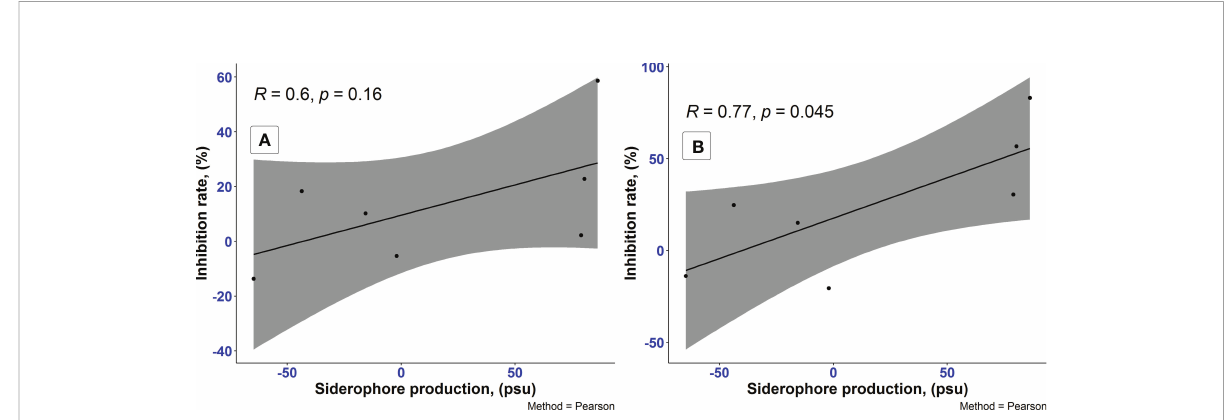
FIGURE 3 Analysis of correlation between the siderophore production of P. resinovorans SZMC 25872 and the growth inhibition of A. tumefaciens SZMC 14557 by 25% (A) and 50% (B) CCF (Table 5), Pearson coef fi cient. Grey color represents 95% con fi dence